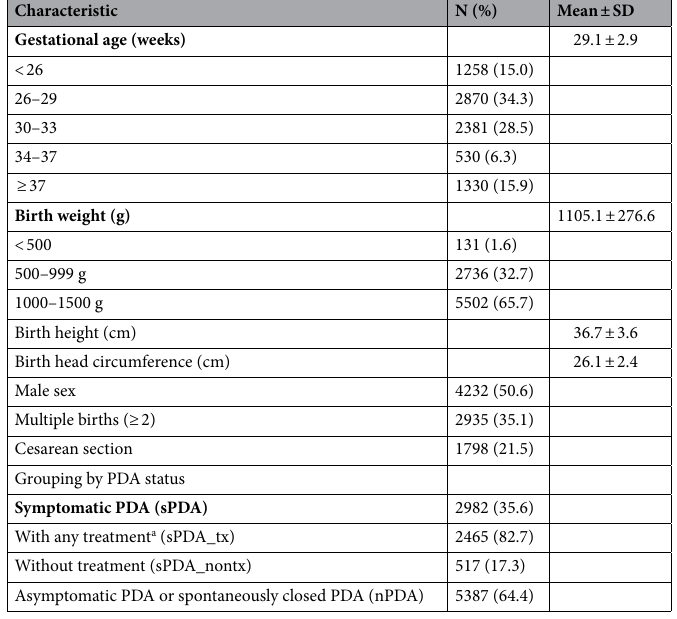
Table 1. Demographic Characteristics of the Study Population (N = 8369). SD, standard deviation; PDA, patent ductus arteriosus. a Treatments for PDA included medications, such as indomethacin and ibuprofen, as well as ligation